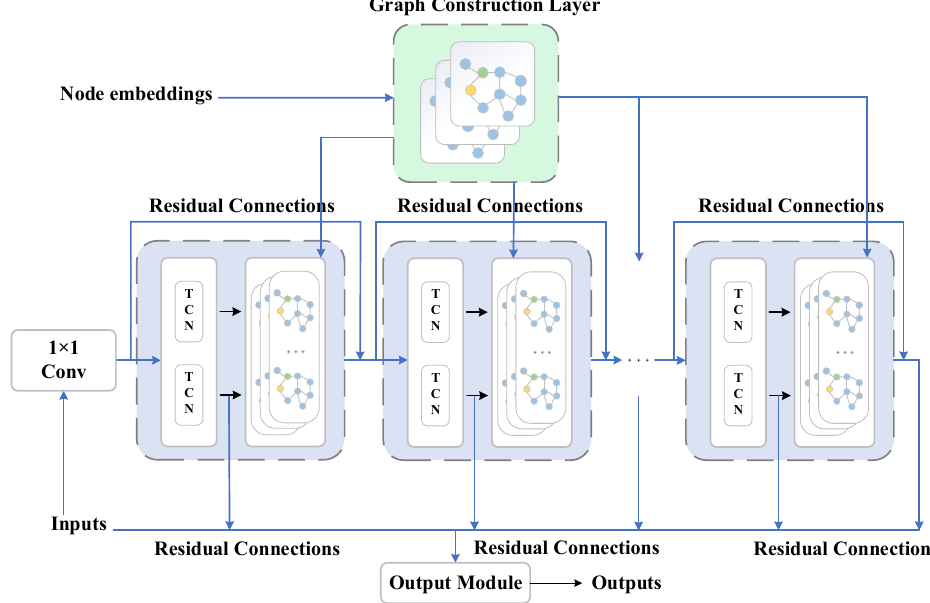
Figure 7. The framework of T-GCN.